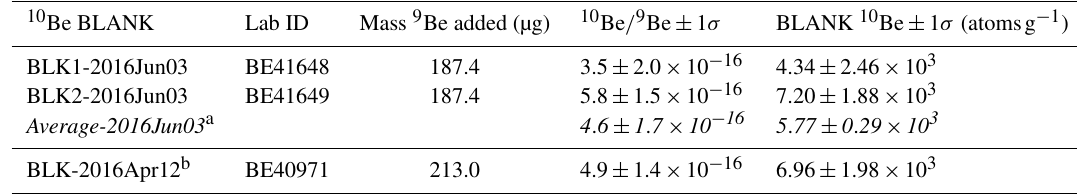
Table 3. Blank corrections for 10 Be in quartz